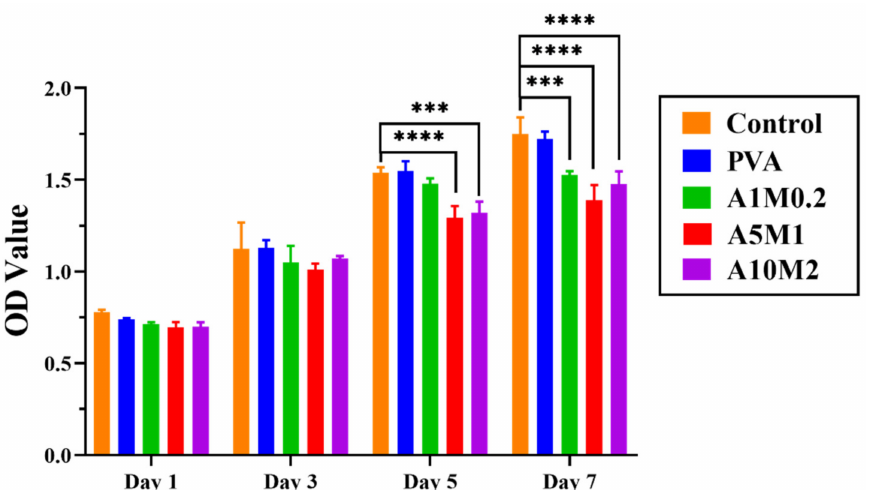
Figure 7. The Cytotoxicity of extracts of PVA and HPX/PVA hydrogels. The error bars indicate the mean ± standard deviations from three independent experiments. Statistical analysis was performed using two-way ANOVA with Dunnett’s multiple comparisons (*** p < 0.001, **** p <